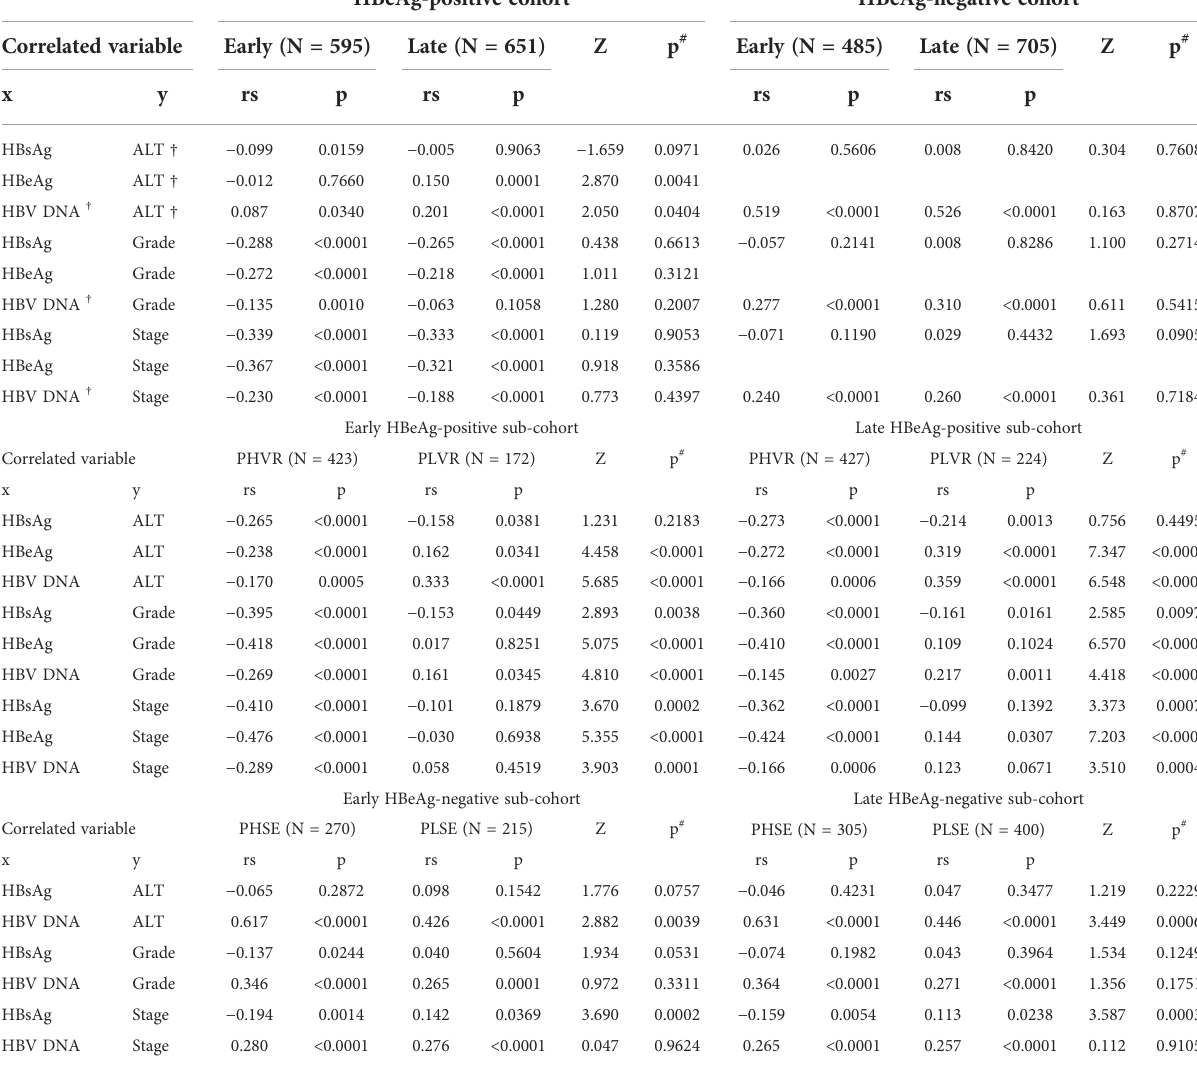
TABLE 2 Spearman ’ s correlation coef fi cients between HBsAg, HBeAg, and HBV DNA and ALT, Grade, and Stage. HBeAg-positive